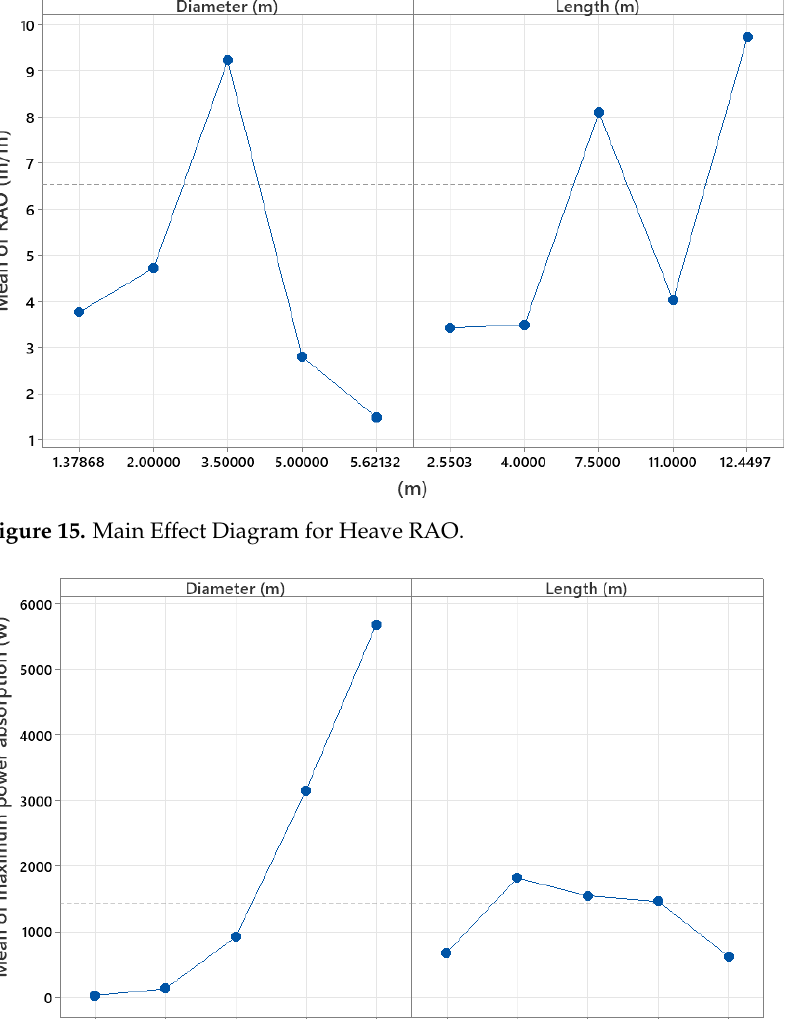
Figure 14. Main Effect Diagram for Force Excitation.